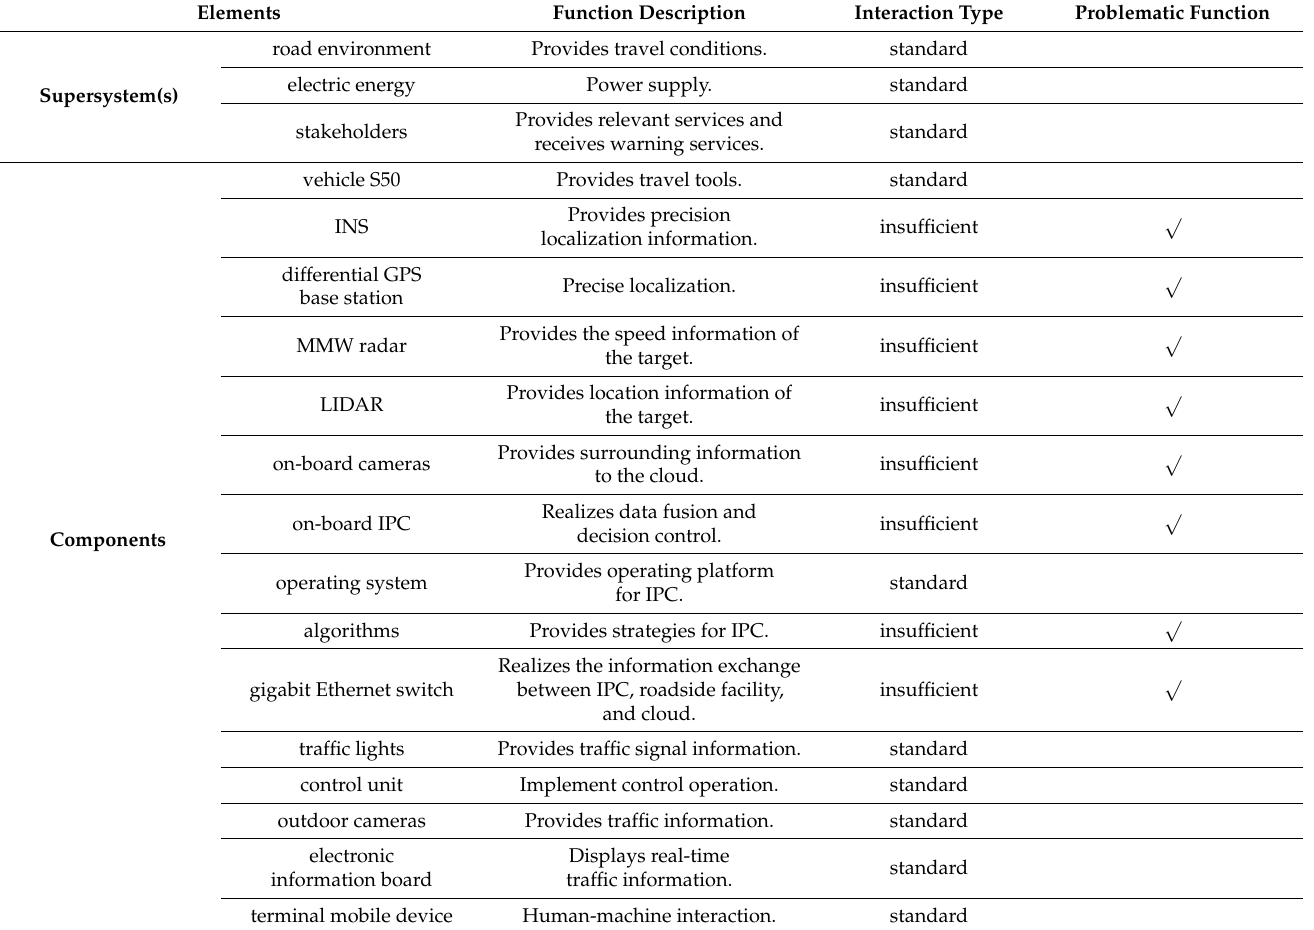
Table 3. Components analysis of extended